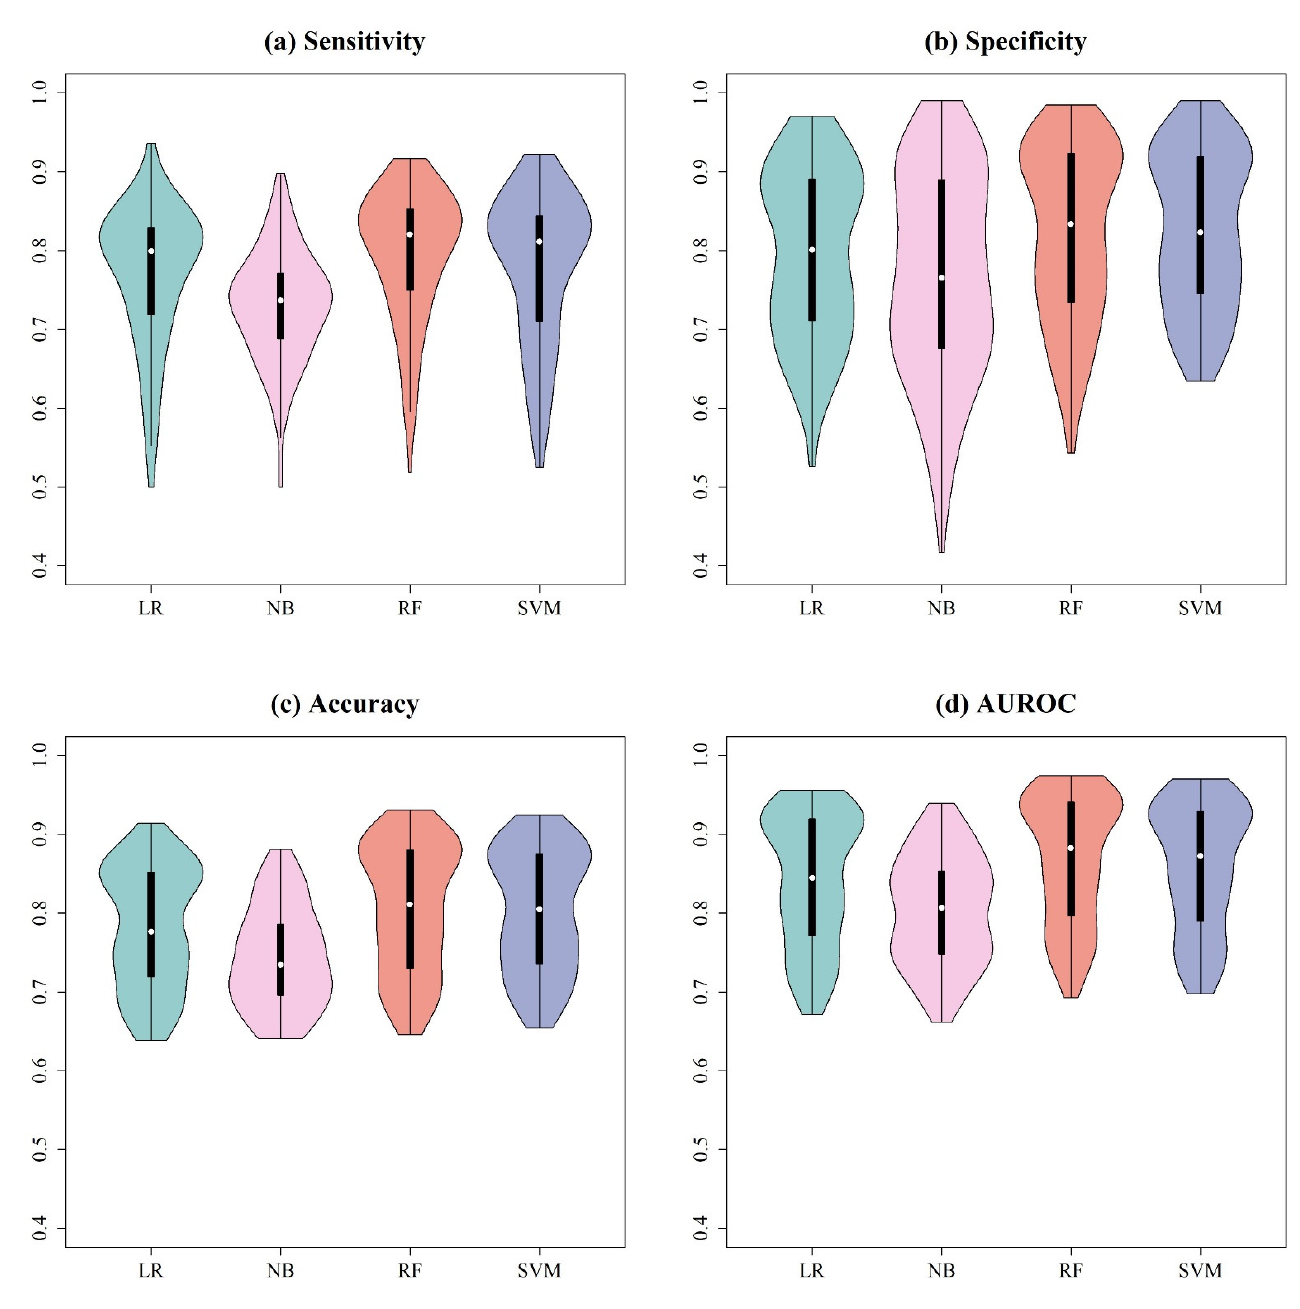
Figure 3. Violin plots for ( a ) sensitivity, ( b ) specificity, ( c ) accuracy, and ( d ) AUROC using different machine learning classification algorithms . The different preprocessing methods were